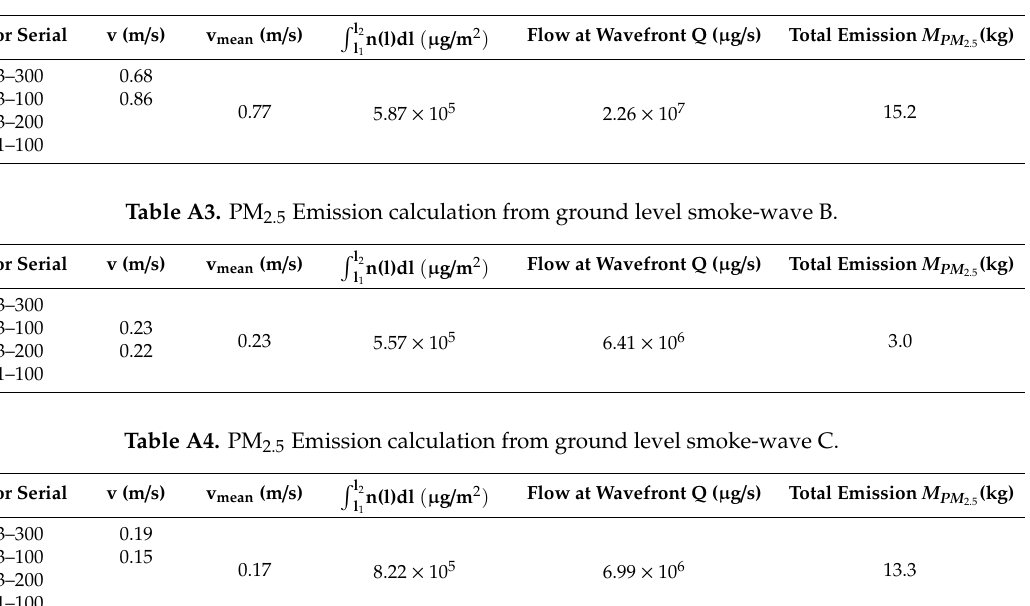
Table A2. PM 2.5 Emission calculation from ground level smoke-wave A.